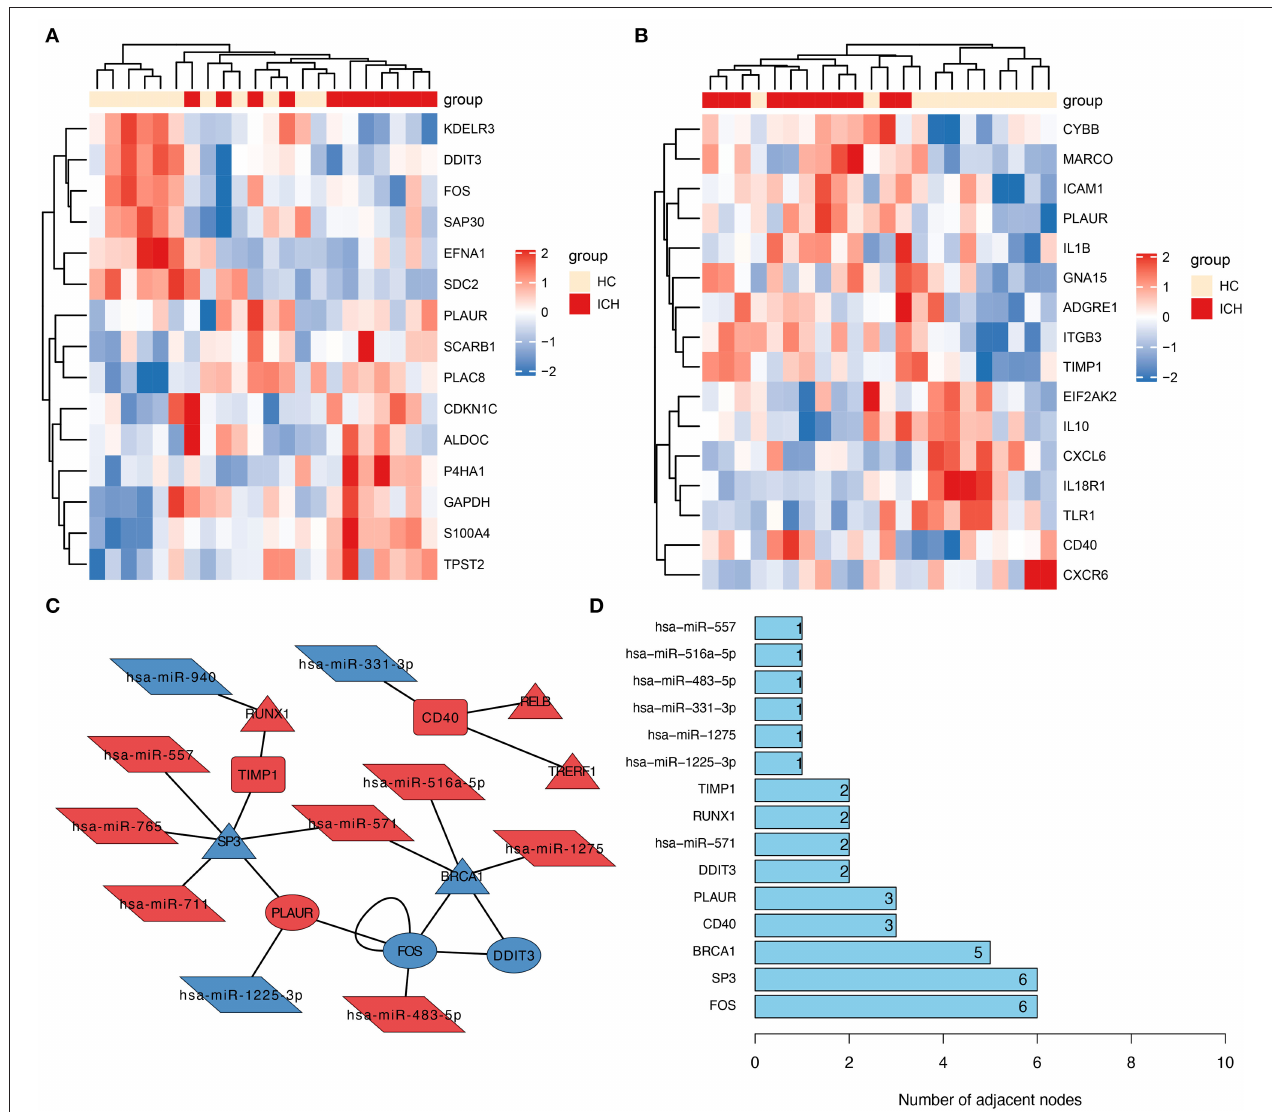
FIGURE 2 | Construction of molecular interactions networks. Heat map showing hypoxia- (A) and inflammation-related (B) DEGs in patients with ICH. The depth of the color was used to indicate the intensity of gene expression. (C) The constructed miRNA–TF–mRNA network. Each node represents a gene and each edge represents a gene interaction. Triangle represents transcription factors, parallelogram represents miRNAs, ellipse represents hypoxia-related genes, and the round rectangle represents inflammation-related genes. (D) Number of junctions between individual genes in this miRNA–TF–mRNA network.